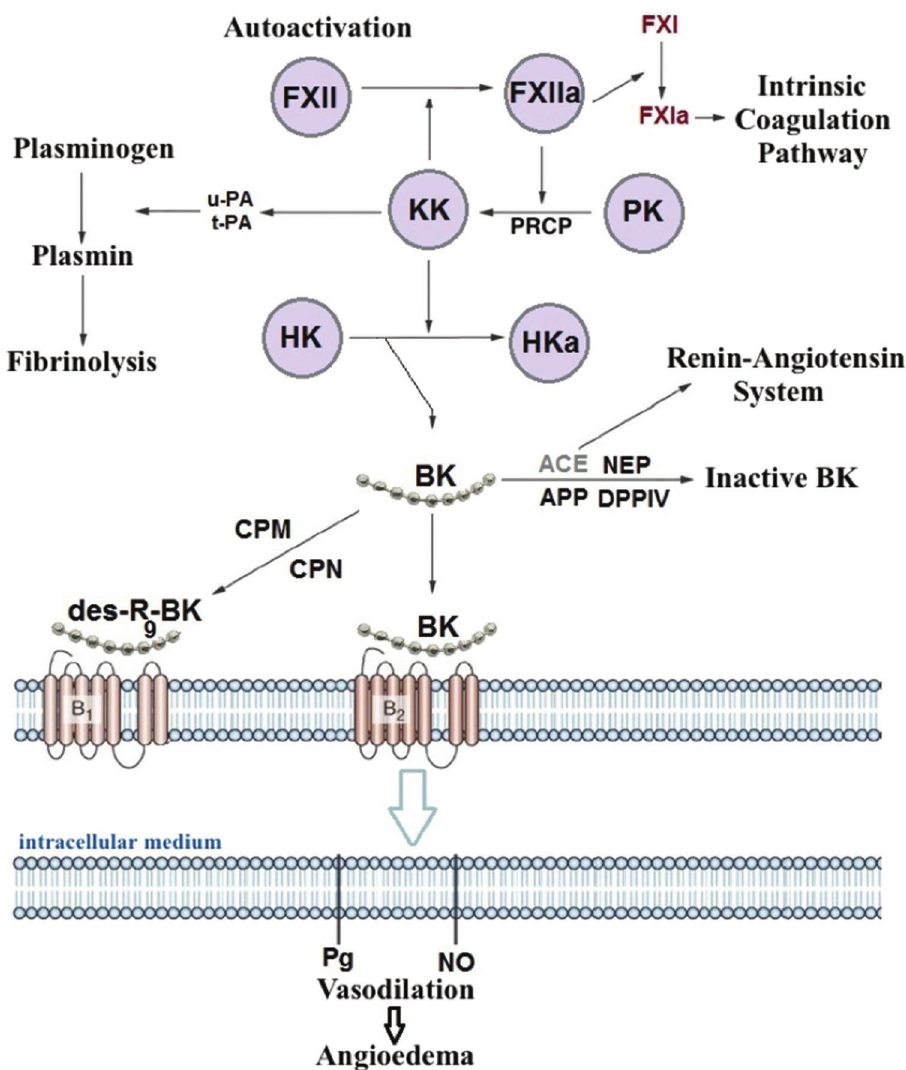
Figure 1 - Kallikrein-kinin